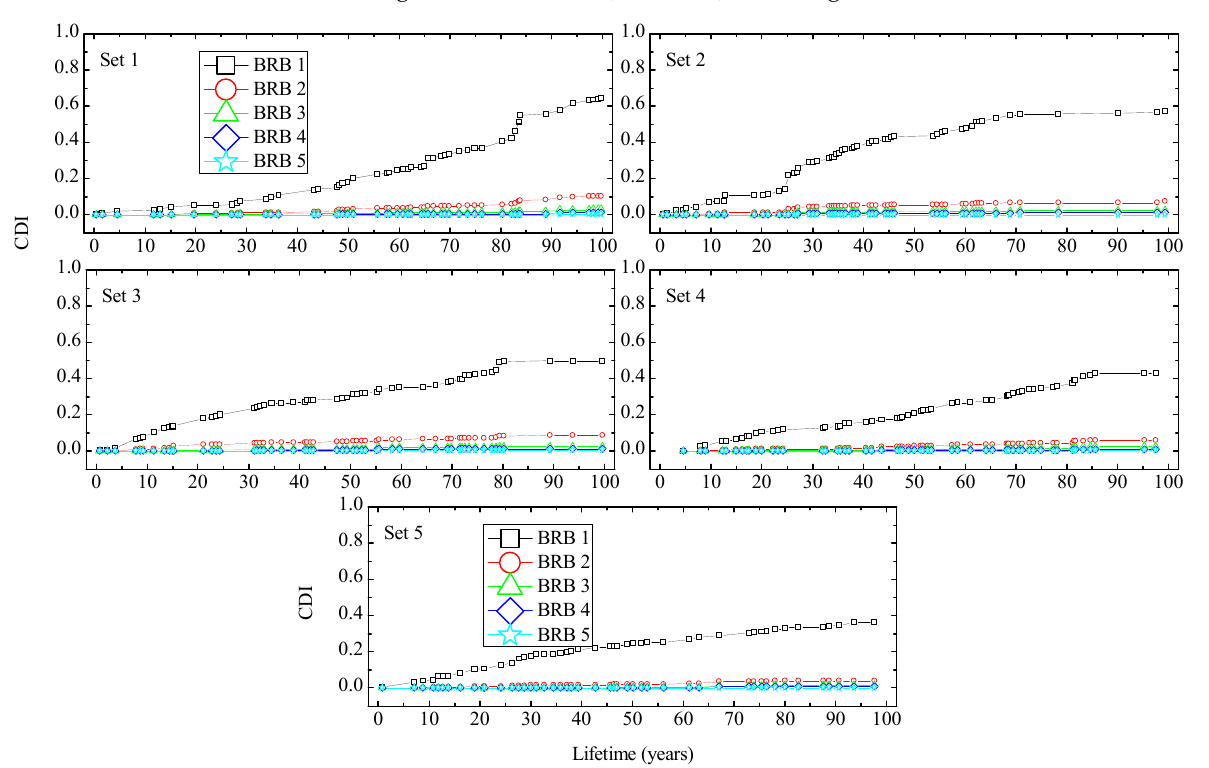
Figure 17. Cumulative damage index (CDI) of selected BRBs under multi-hazard scenarios.